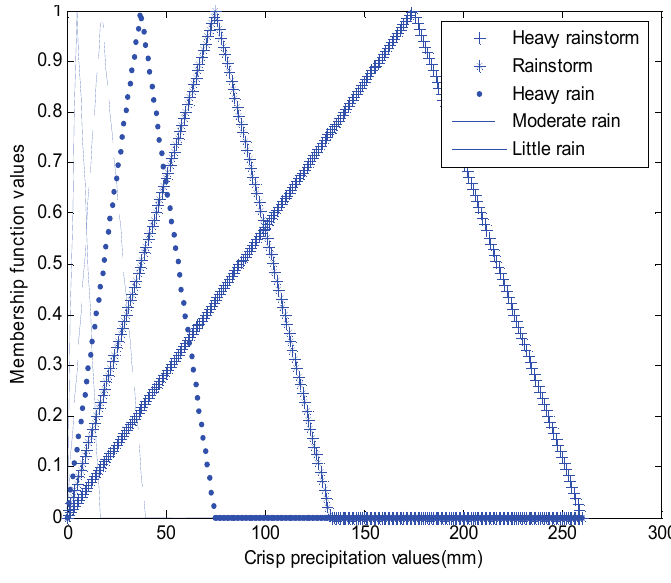
Figure 4. Membership function curves of meteorological fuzzy variable